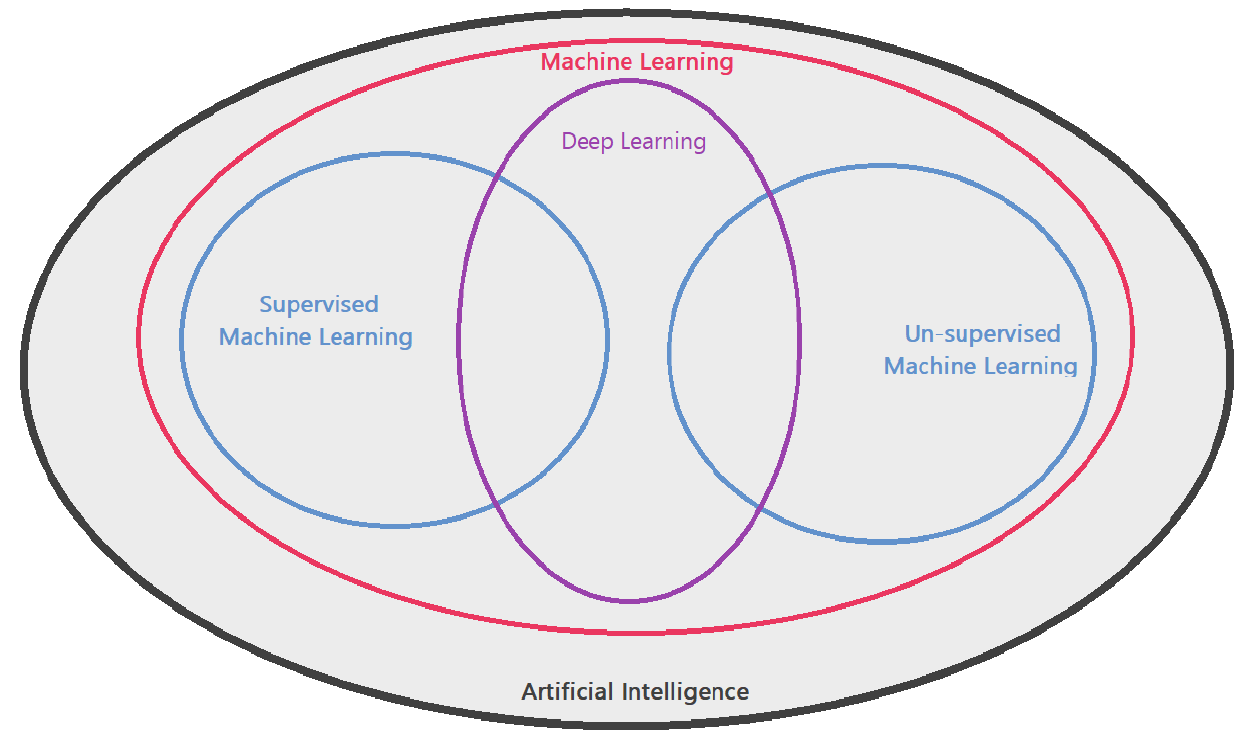
Figure 1. A Venn diagram visually explaining AI and machine learning relationship.